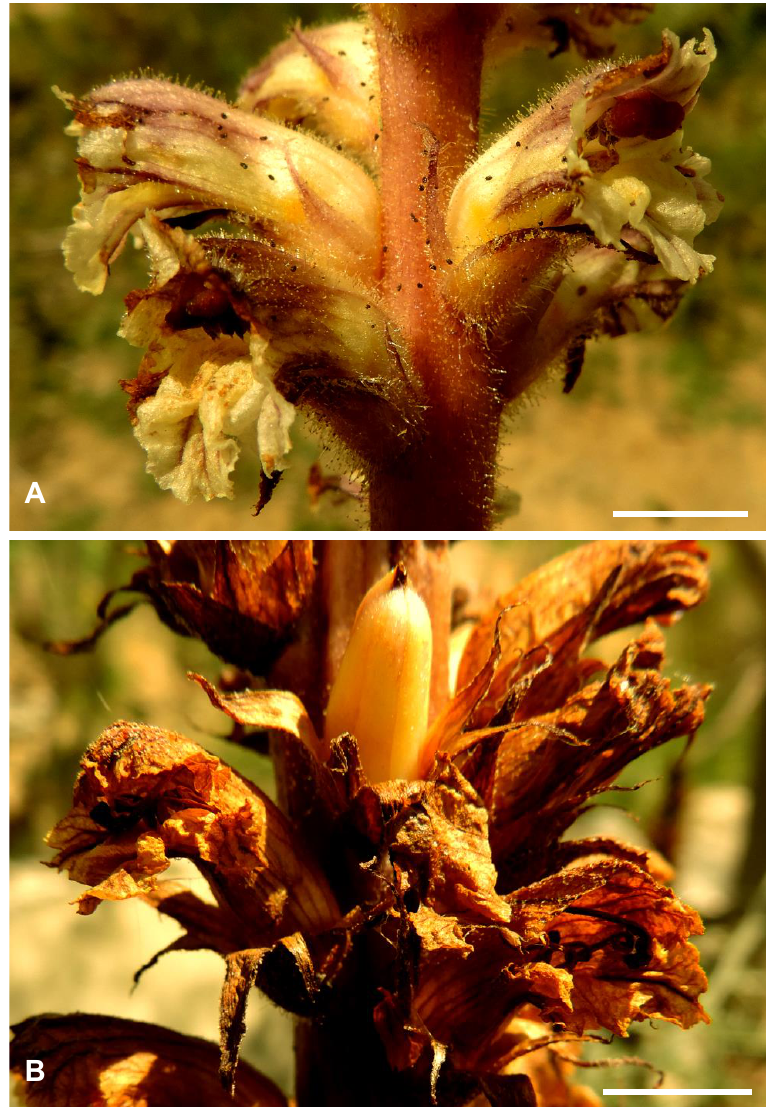
Figure 3. Orobanche dominae El Mokni sp. nov. A, Lax glandular hairy inflorescence with details of bilobed violet to purple stigma on the upper part of an opened flower within a juvenile specimen (scale bar = 1 cm); B, Details of mature yellow-reddish ovary with bidentate, narrowly lanceolate halve within a mature specimen (scale bar = 1 cm). Photographed by R. El Mokni